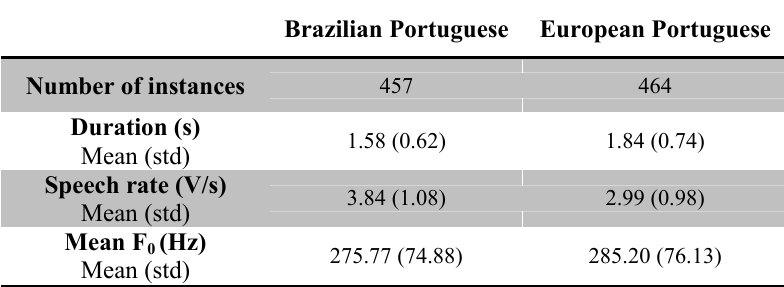
Table III: Basic statistical information about the utterances grouped by Portuguese speech variant.